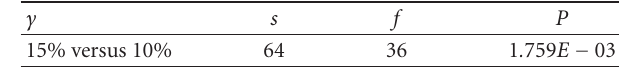
Table 4: Number of successes and failures and P